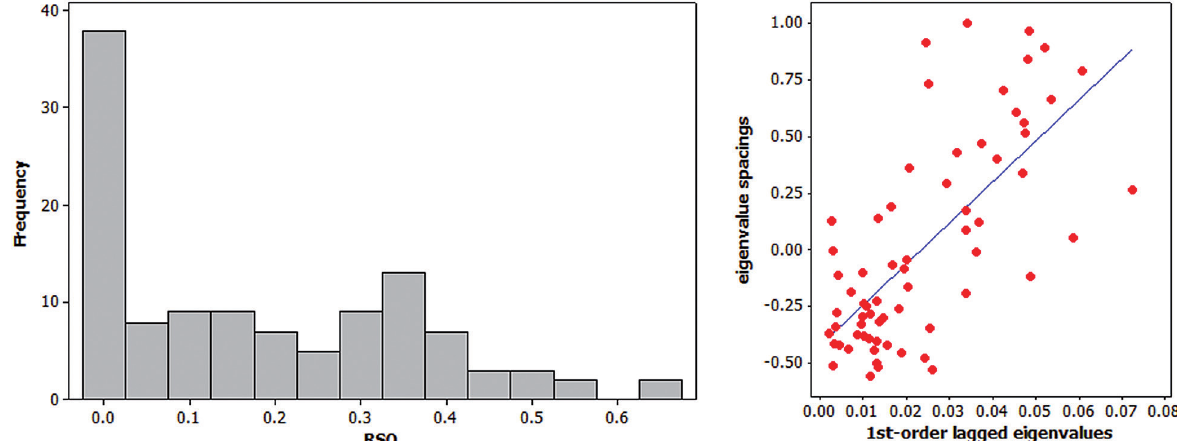
Fig. 3. Latent structure in sequences of matrix W eigenvalue spacings Left (a): histogram of R 2 values from bivariate regressions predicting eigenvalue spacings from 1st-order lagged eigenvalues. Right (b): scat- terplot of the Alabama county tessellation ( n = 67) results for which R 2 =